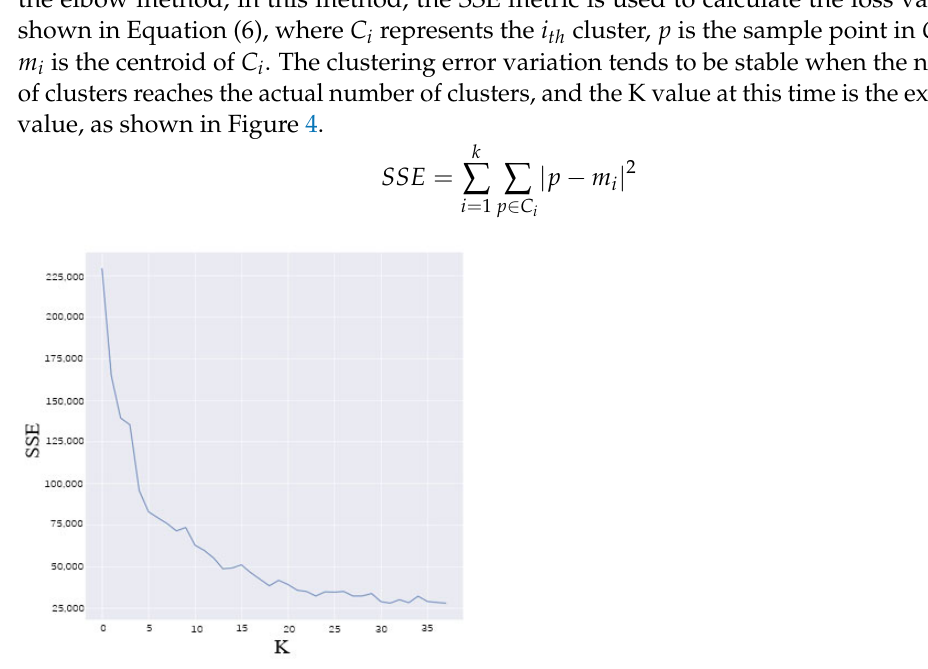
Figure 5. Silhouette coefficients for different K values. 3.3. Clustering Result Figure 6 shows the comparison of trajectories before and after clustering. It can be seen that, before clustering, various trajectories are intertwined, and the route distinction is not obvious. For example, in the entire airspace, the flight path of the aircraft is affected by the terrain or the purpose of the flight. It is challenging to build a prediction model in the entire area to obtain a good prediction effect. In this paper, through trajectory cluster ‐ ing, the trajectory of the entire airspace was divided into six routes, each of which repre ‐